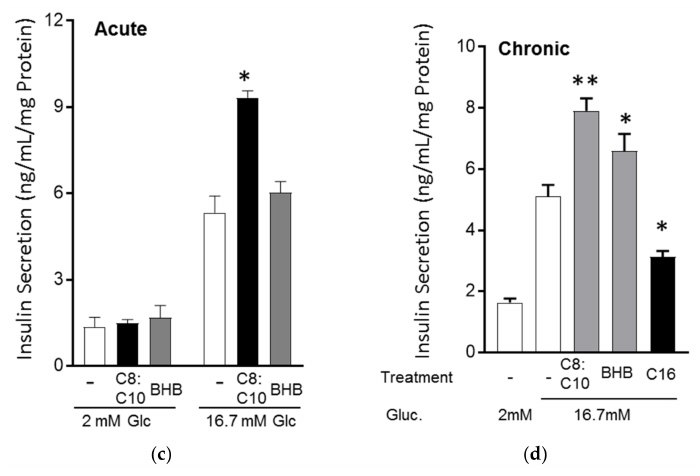
Figure 4. Regulation of insulin secretion by MCFA and BHB in INS1E cells. ( a ) Increase of calcium mobilization by C8 and C10. ( b ) Acute statistic insulin secretion after 1 h of treatment with secretagogues, like 1 × amino-acids (A), 0.1 µ M Exendin-4 (Ex) and 200 µ M fatty acids—palmitate (PA, C16:0), C8, C10, in low (2 mM) and high (16.7 mM) glucose or ( c ) 200 µ M C8:C10 40:60 mixture or 200 µ M of BHB. ( d ) Static insulin secretion after chronic (72 h) treatment with 200 µ M of C8:C10 40:60 mixture, BHB or palmitate (P). Data represent means + SEM of three independent experiments, * p < 0.05, ** p < 0.01 relative to